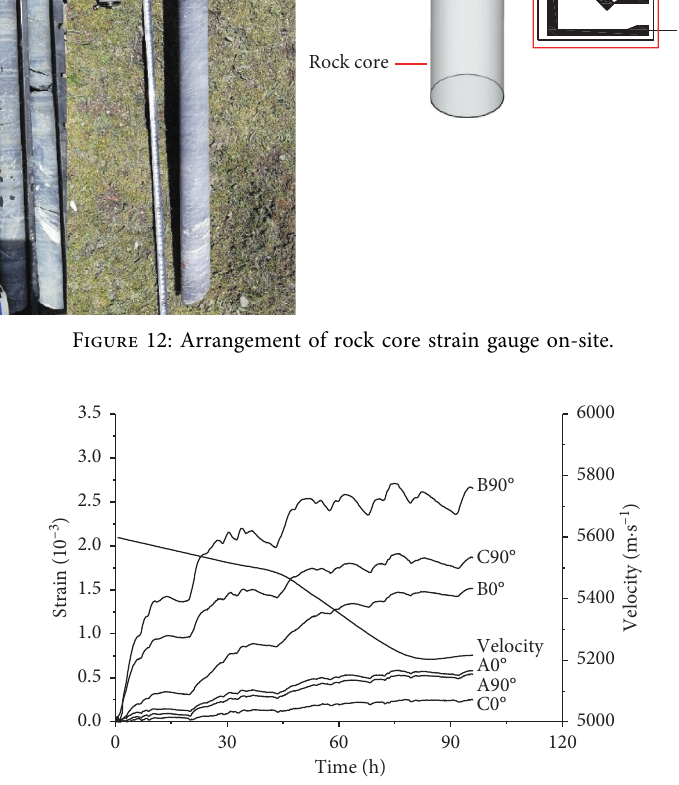
Figure 13: Field strain and ultrasonic wave velocity monitoring.